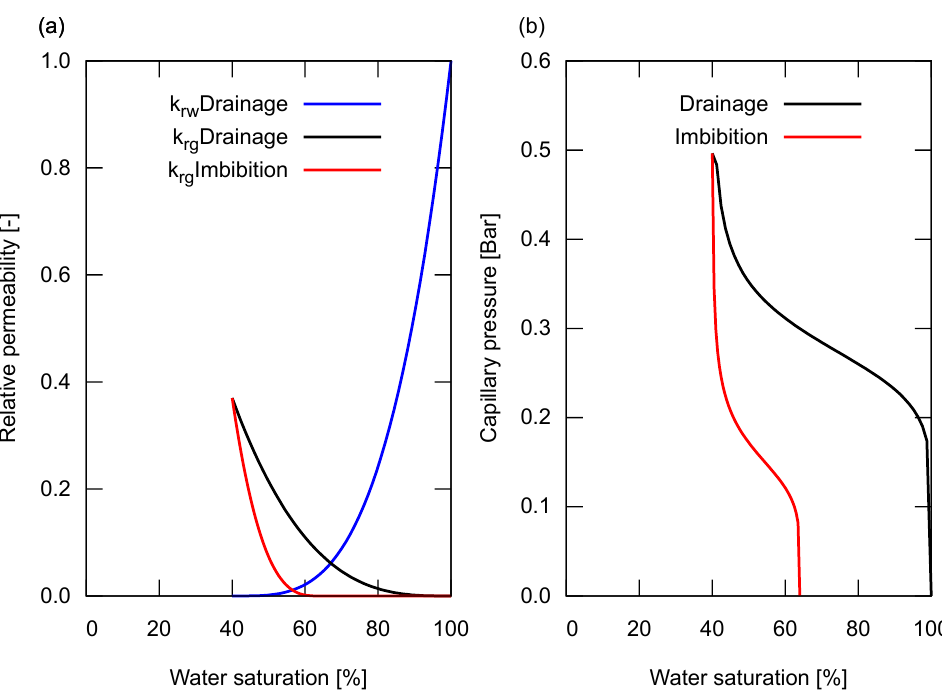
Figure 2. Saturation functions used in the study. ( a ) The relative permeability curves for water and gas. The hysteresis in drainage and imbibition was considered for the gas relative permeability shown in black and red, respectively. For the water relative permeability, a single curve was used for both drainage and imbibition shown in blue; ( b ) The capillary pressure curve for drainage is shown in black, and imbibition is shown in